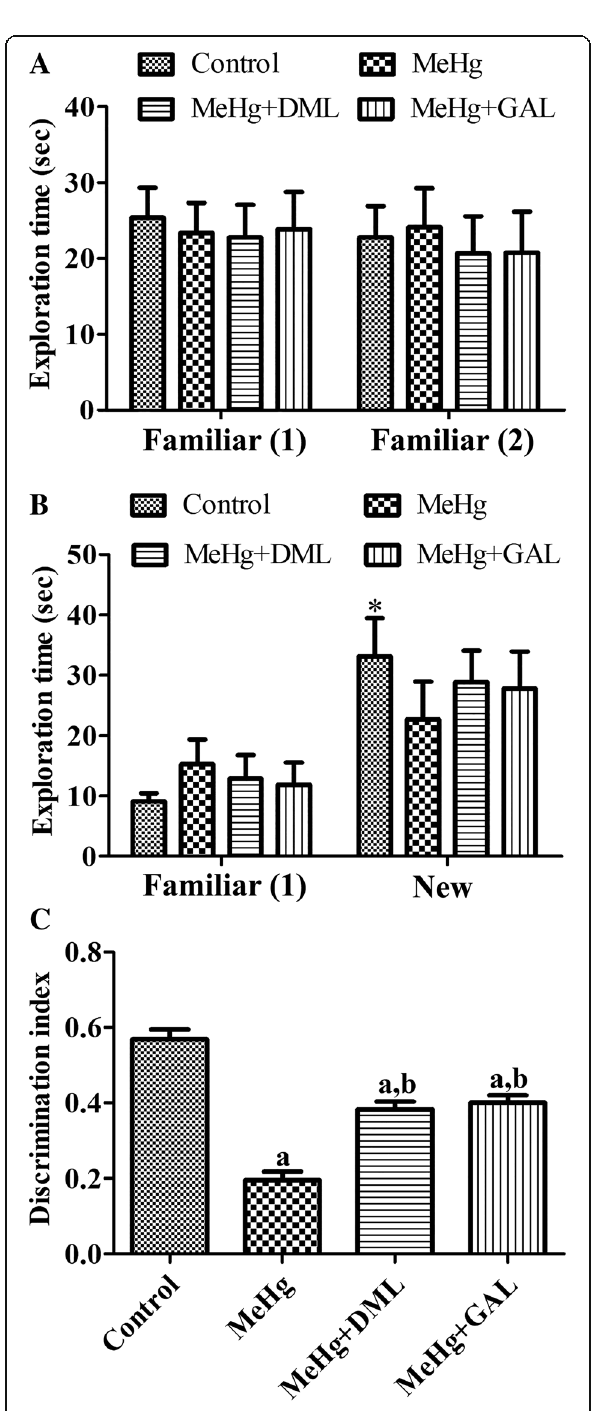
Fig. 2 Exploration time in training (A) and testing trials (B), and discrimination index (C) in the control group, dimethylmercury (MeHg)-treated group, Dendropanax morbifera leaf extract treated group with MeHg (MeHg + DML), and galantamine (GAL) treated group with MeHg (MeHg + GAL) ( n = 5 per group; * p < 0.05, vs. familiar object; a p < 0.05, vs. control group; b p < MeHg-treated group). All data are shown as % exploration time ± standard error of the mean. Note that training trial does not show any remarkable differences on exploration time. In contrast, control group shows increased exploration time in new object compared to that in the MeHg group, while exploration time is decreased in MeHg group. In the MeHg+DML and MeHg+GAL groups, exploration time in new object is increased. In addition, discrimination index is significantly decreased in the MeHg group compared to that in the control group. In the MeHg+DML and MeHg+GAL group, discrimination index is remarkably increased compared to that in the MeHg